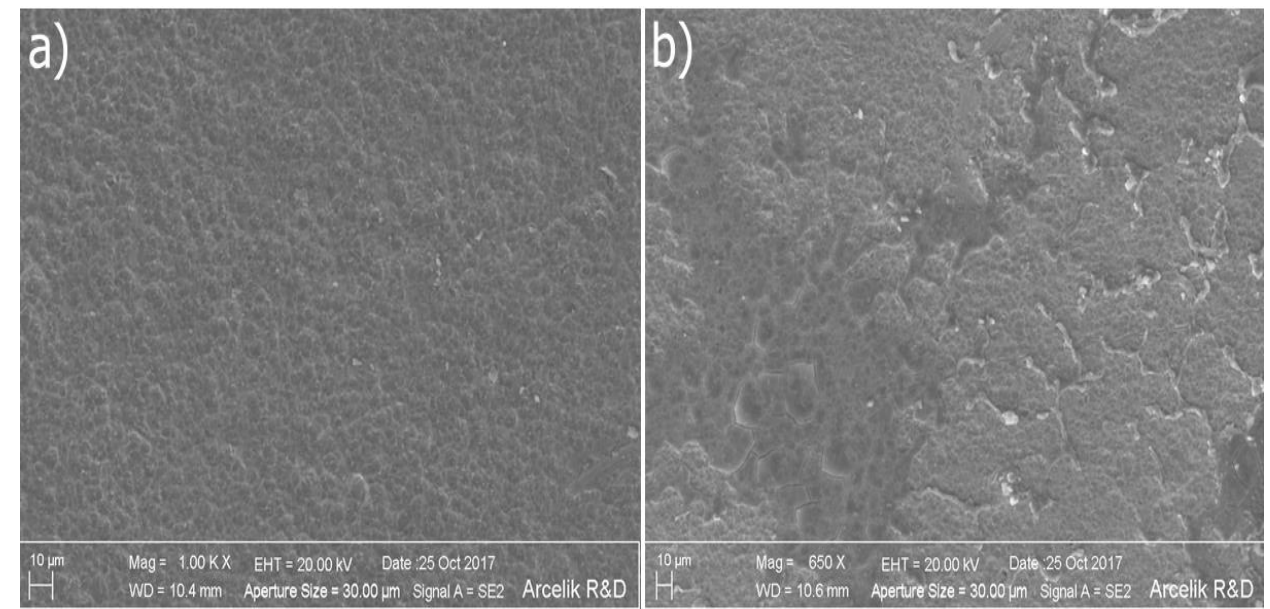
Figure 6. SEM images of Ti-based anodes: ( a ) Ti-based anode at the beginning of the experiments; ( b ) Ti-based anode at the final of experiments.